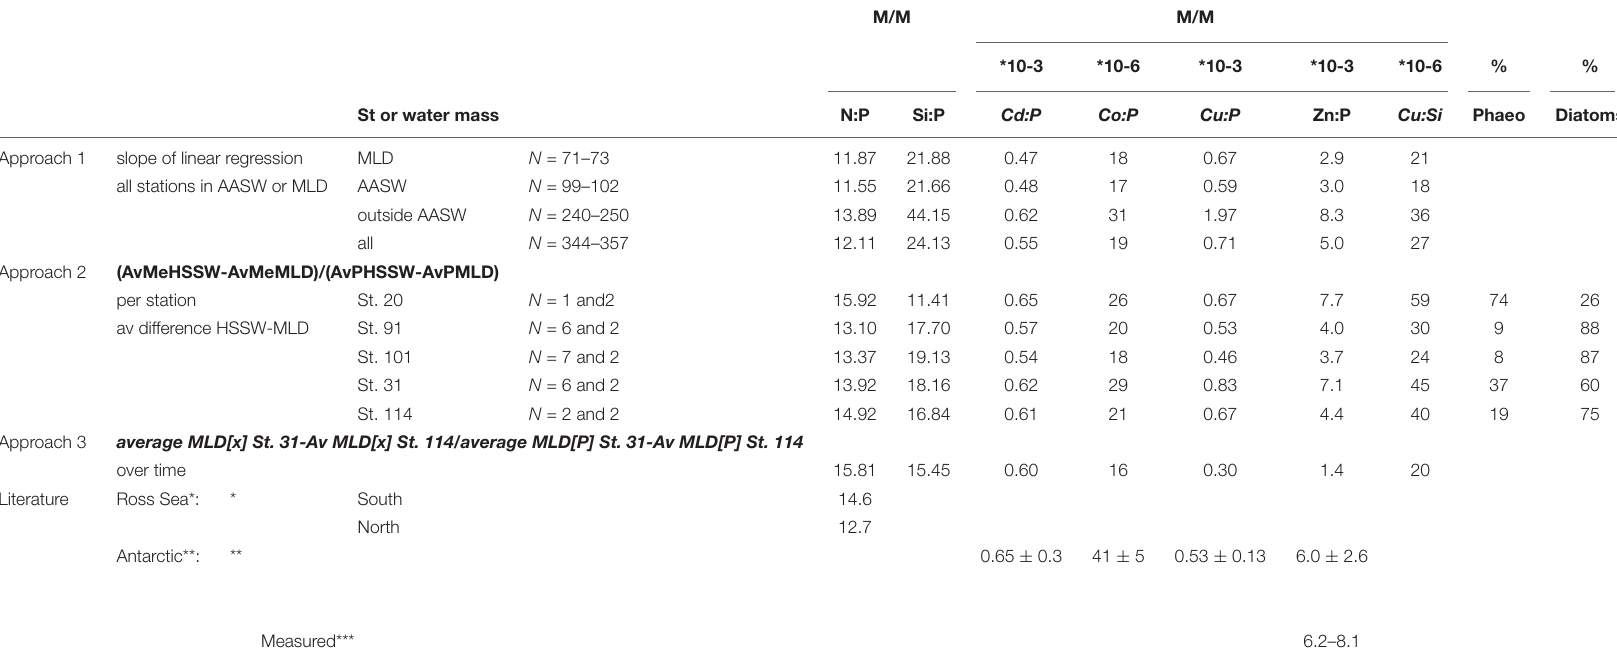
Approach 1: Slopes of linear relationships with PO 43 − and for Cu also with Si(OH) 4 per defined water layer or water mass, Approach 2: per station ratios of the differences between average concentrations in the ML and the HSSW (Average[x] in HSSW-Average [x] in ML)/(Average [PO 43 − ] in HSSW- Average [PO 43 − ] in ML). Approach 3: ratios of the differences of average concentrations in the ML between St. 31 and 1114, a time difference (average [x] in ML at St. 31-average [x]in ML at St. 114)/(average [PO 43 − ] in ML at St. 31-average [PO 43 − ] in ML at St. 114. Literature values are from: * Fitzwater et al. (2000) obtained in the Ross Sea. ** after Twining and Baines (2013) compiled from Antarctic data from Löscher (1999); Ellwood (2008), Lane et al. (2009); Bown et al. (2011), Croot et al. (2011). *** Twining et al.,